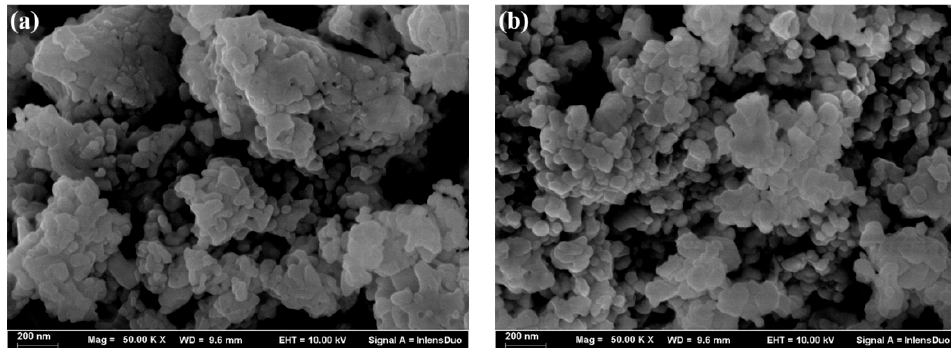
Figure 2. SEM images of BiFeO 3 nanocrystals: ( a ) 500 ◦ C and ( b ) 550 ◦ C.